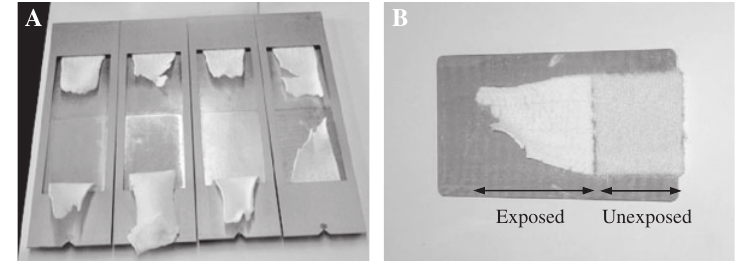
Figure 4 GTX W0 after 250 h of artifi cial weathering: (A) general view of the specimens after the test; (B) detailed view of a damaged specimen.